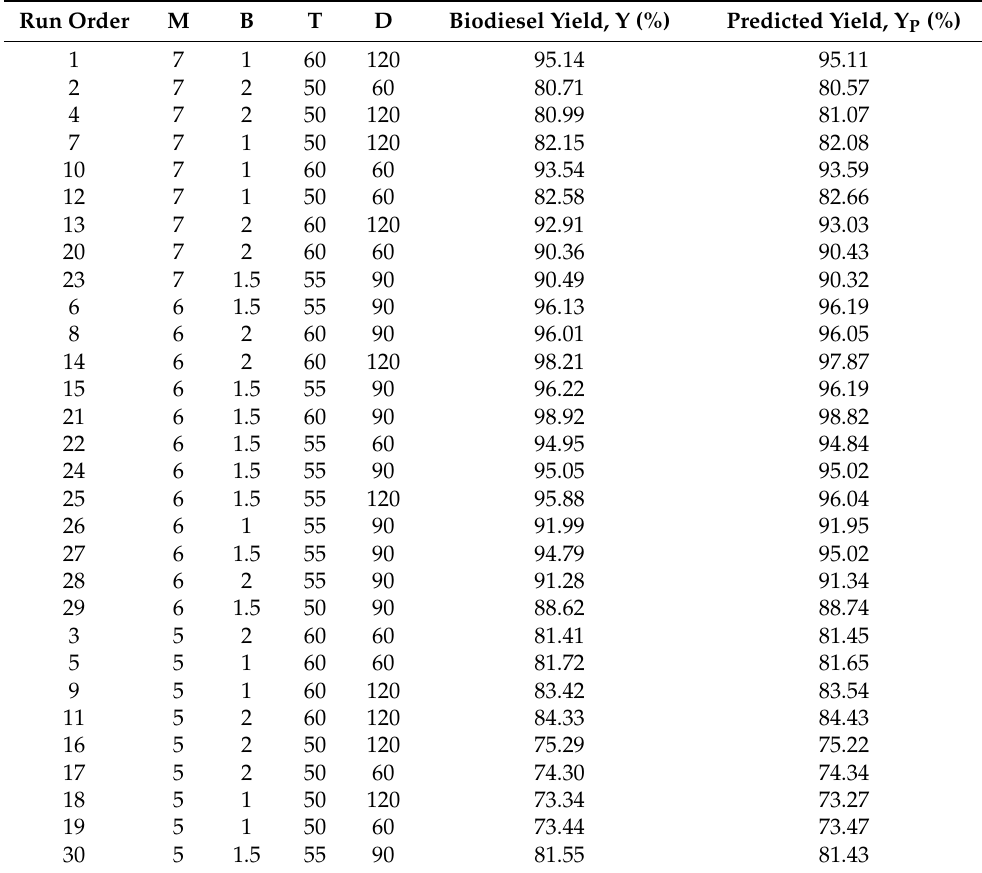
Table 13. RSM analysis of the transesterification process of the esterified